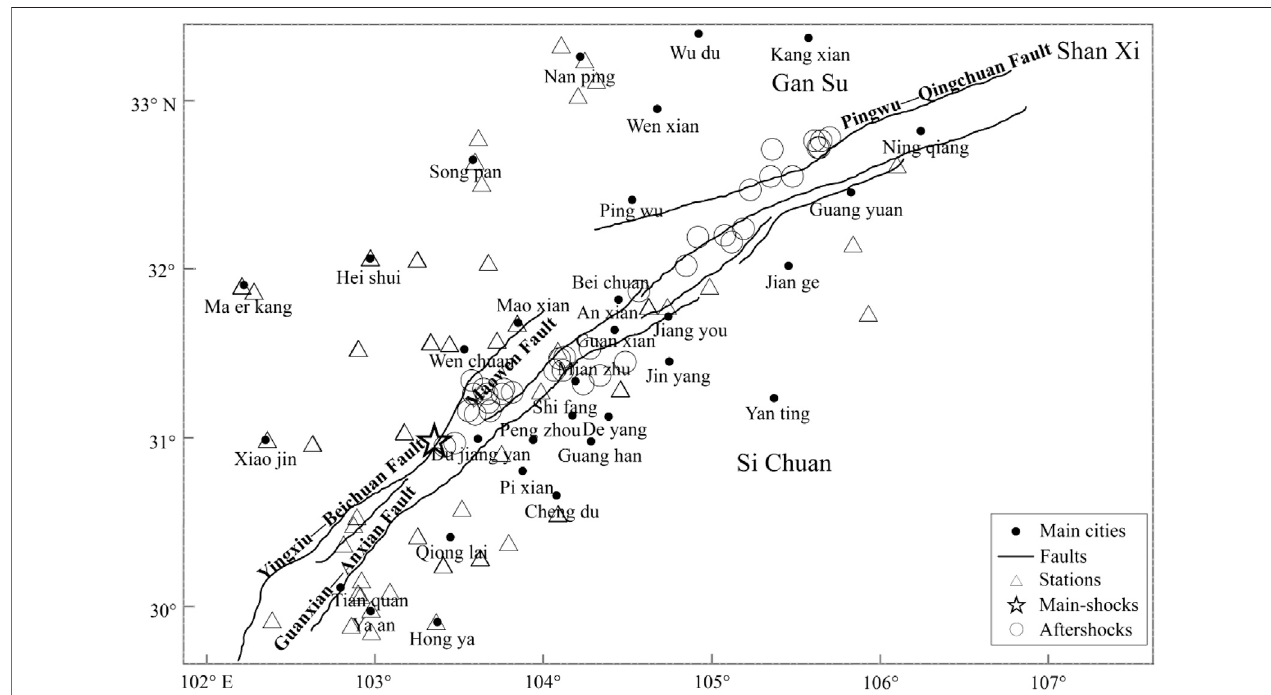
FIGURE 1 | Map of stations (triangles) and the main-shock (star) together with the aftershocks (circles) used in this study. A sketch indicating the surface rupture area.